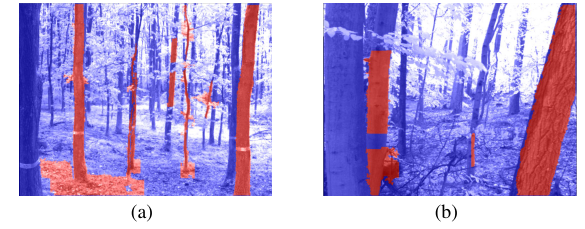
Figure 3. Results of stereo vision based image segmentation algorithm.